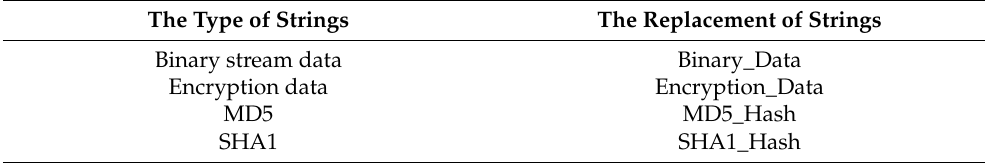
Table 3. The rule of string replacement.